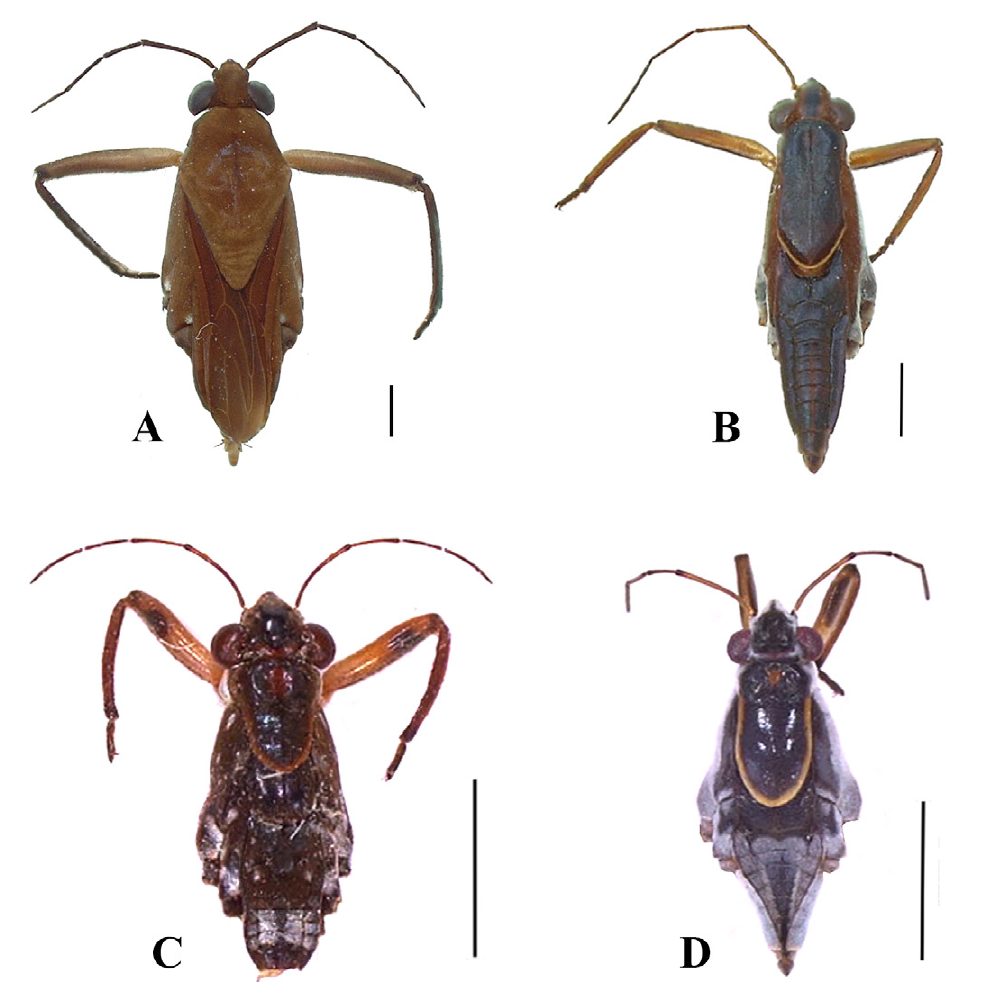
Figure 1. Habitus, dorsal view. A. Brachymetra shawi . B. Limnogonus ignotus . C. Neogerris lotus . D. Neogerris